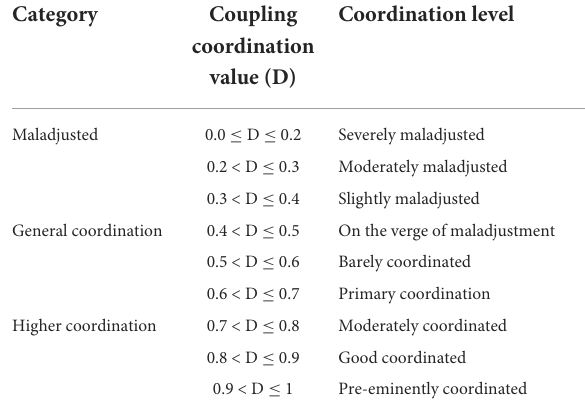
TABLE 3 Coupling coordination degree level type of LCD quality/TI capability/NU